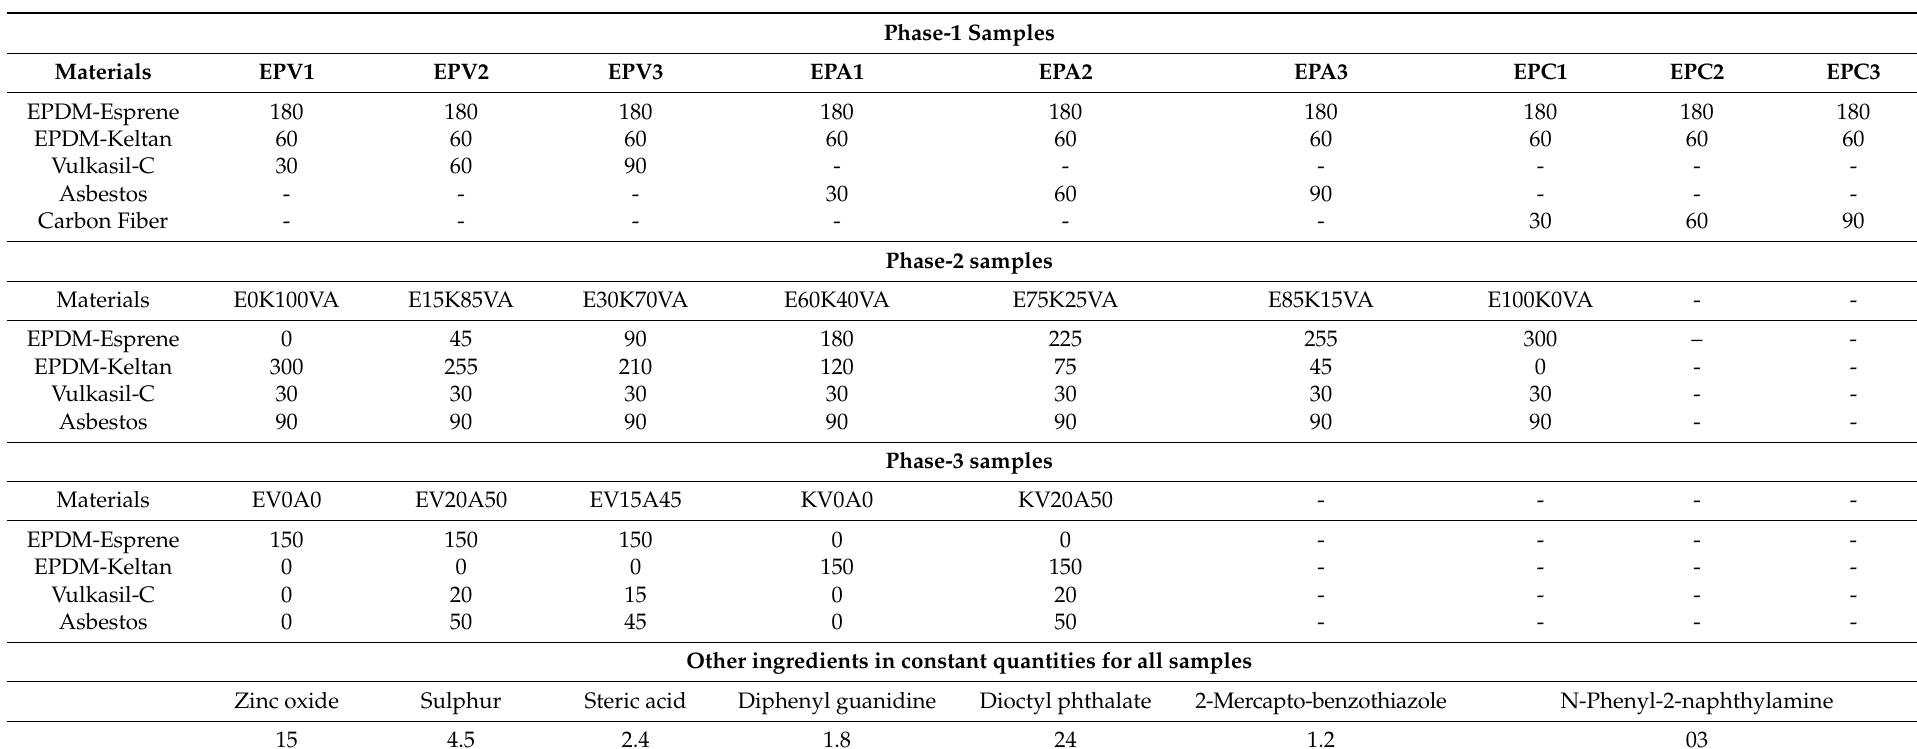
Table 1. Compositions of ingredients of phase -1, -2, and -3 samples in